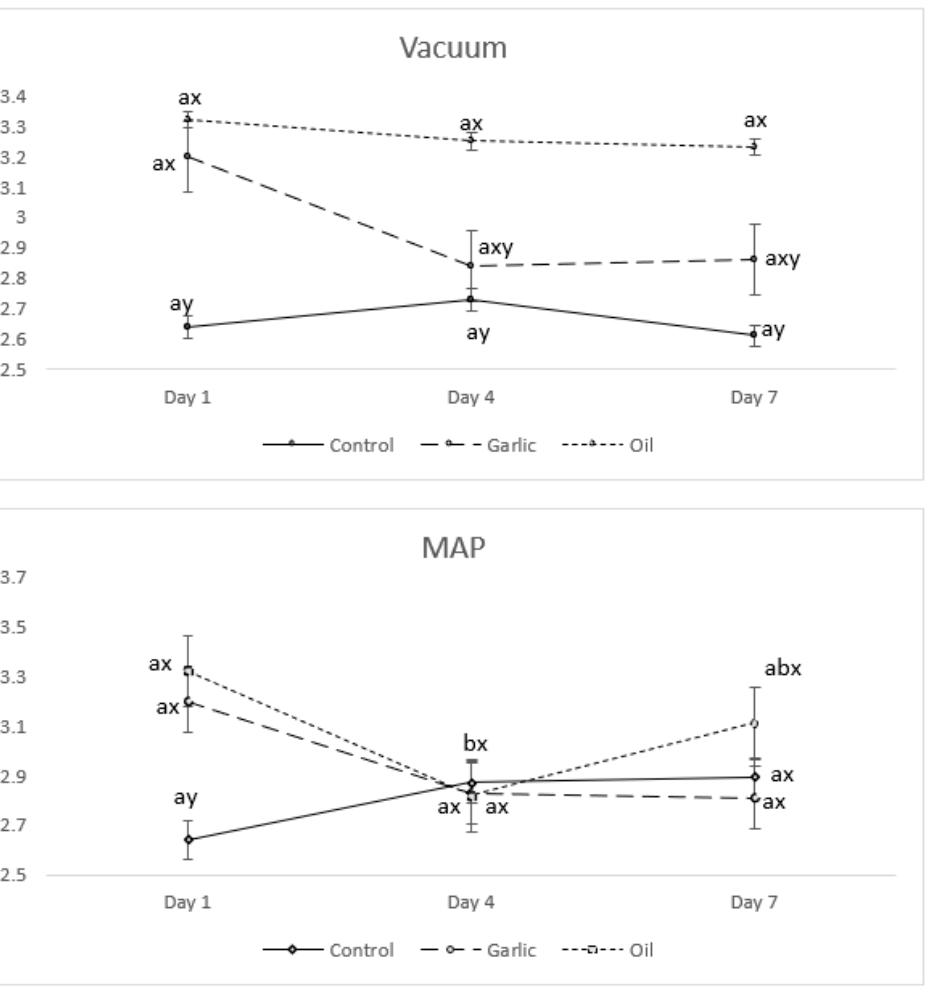
Figure 3. Shear stress values as a function of the PDE, packaging type and storage time, a, b.— differences between days ( p < 0.05), for a certain PDE; x, y.—differences between PDE ( p < 0.05) for a certain day. Bars represents the standard error.